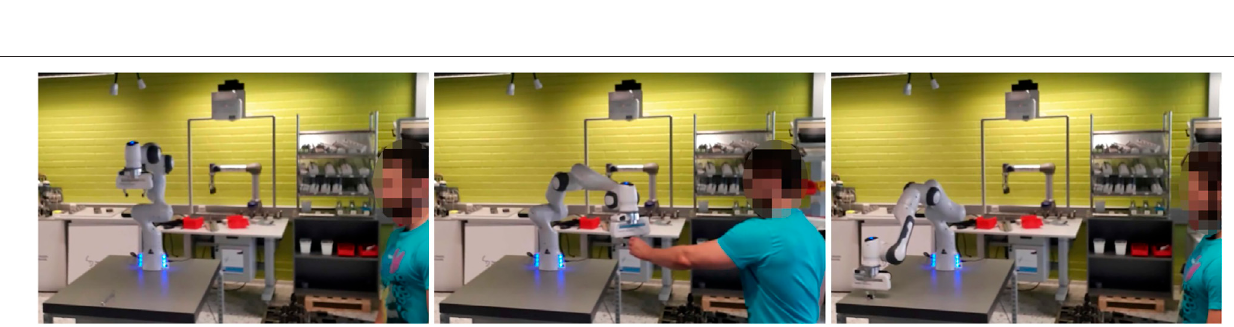
FIGURE 6 | Task assignment chart for the kitting task by graphical command-based coordination. The chart depicts only the actions of the robot (green), as it acts alone.